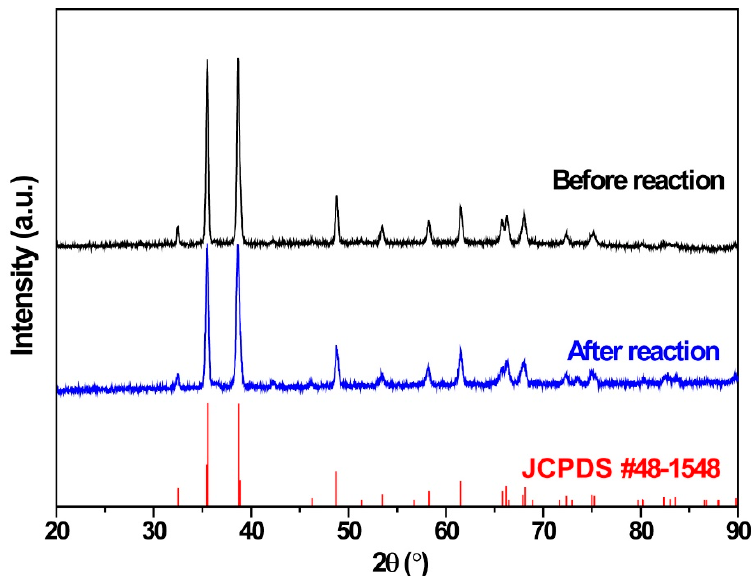
Figure 2. XRD patterns of CuO foam before and after IPC reaction with Joint Committee on Powder Diffraction Standards (JCPDS) data.